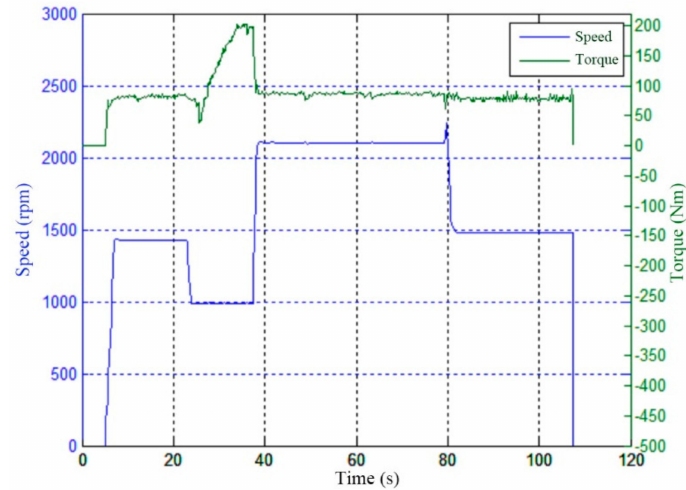
Figure 21. Working condition experiment.